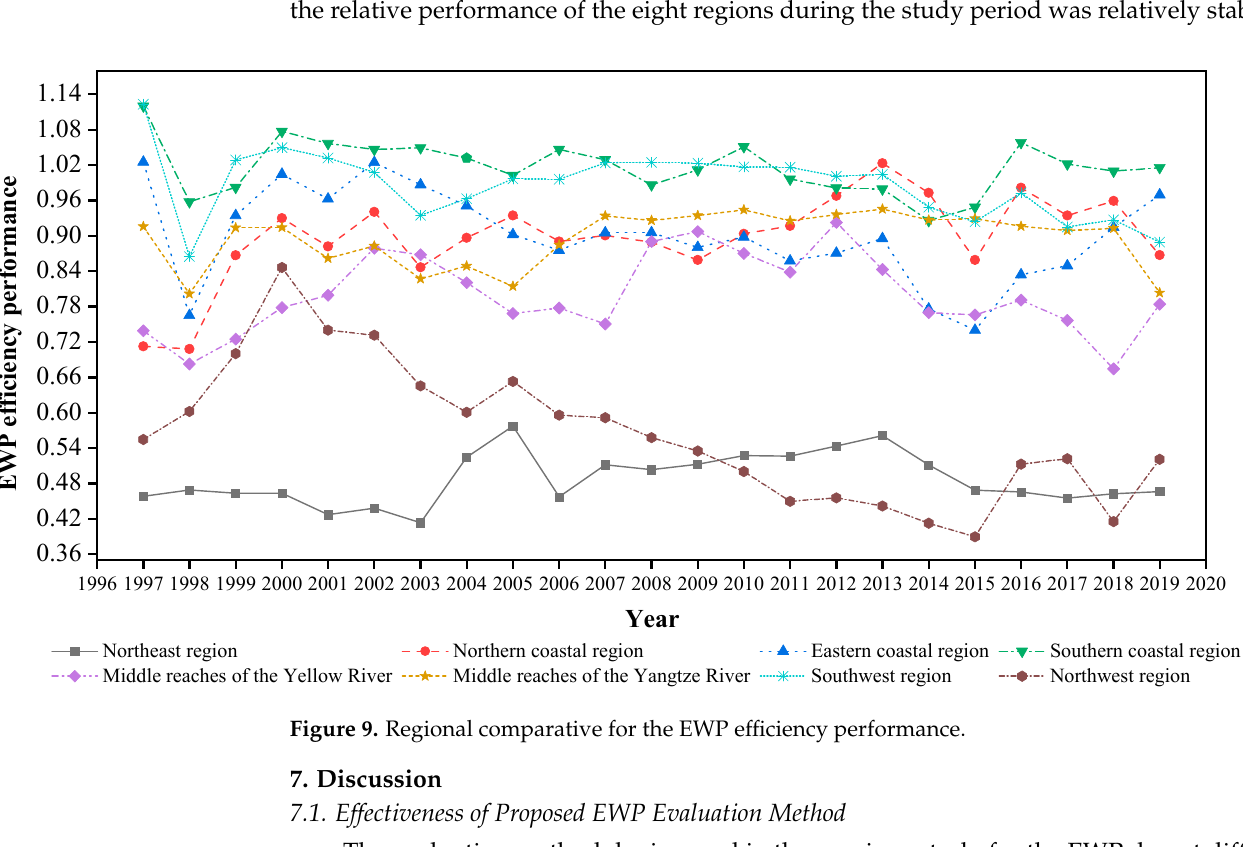
Figure 9. Regional comparative for the EWP efficiency performance.